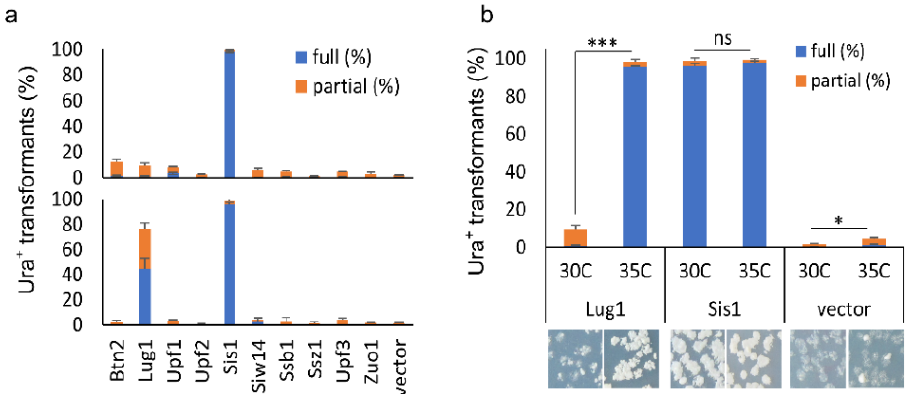
Figure 4. Examination of [ SWI + ]-curing activities of a group of documented anti-prion proteins: ( a ) all 10 indicated proteins were expressed in 2 µ plasmids, driven either by their native promoters (with plasmids from the MoBY 2.0, upper panel) or by GAL1 promoter in a 2 µ plasmid (lower panel). Transformants of LY770 grown on SC–leu plates (for endogenous promoters) and sucrose-based SC–leu plates with 2% galactose (for GAL1 promoter) were replica-plated onto SC–leu–ura after 3 days of growth. Transformants that fully (full (%)) and partially (partial (%)) grew on uracil-minus SC plates (Ura + ) were then scored after 3 days of incubation; ( b ) assays were performed similarly to ( a ) except that transformants were either grown in an optimal temperature (30 °C) or in an elevated temperature (35 °C), with representative images shown at the bottom. Significance was estimated by t -test with the criterion—not significance (ns), p > 0.01; *, p < 0.01; ***, p < 0.0001. Data in this figure were from three independent transformation experiments. Vector, p425GAL1 .